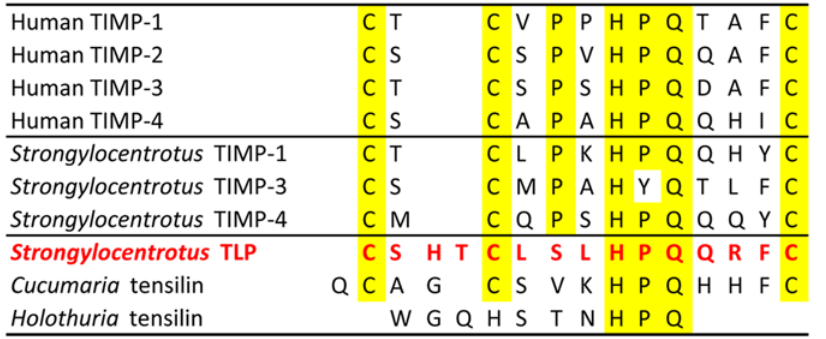
Fig 8. Comparison of amino acid sequences. Alignment of the amino acid sequences of the immediate N- terminal domains of human and sea-urchin TIMPs, holothurian tensilins and Strongylocentrotus tensilin-like protein. Identical amino acids are highlighted. (Sources: [28 – 30], [95], [107]).